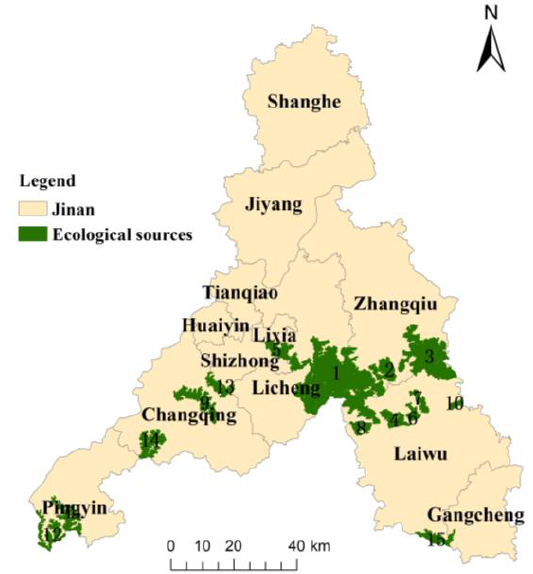
Figure 6. Ecological sources based on MSPA.